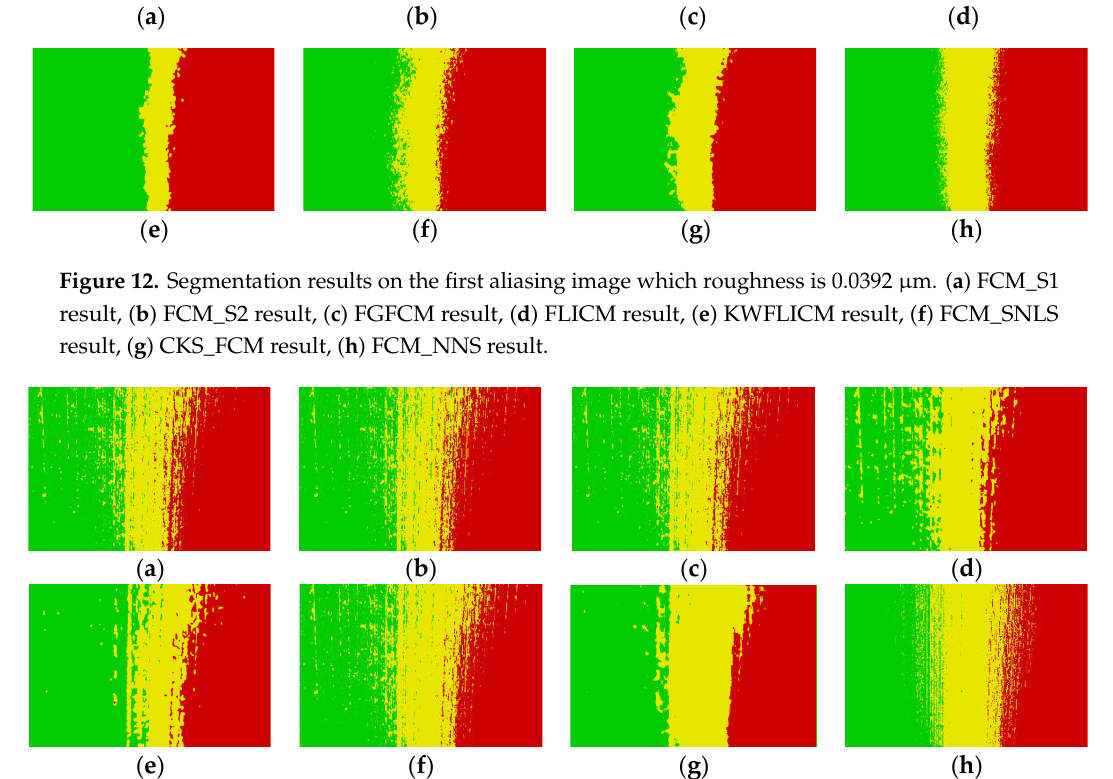
Figure 13. Segmentation results on the second aliasing image which roughness is 0.4261 μm . ( a ) FCM_S1